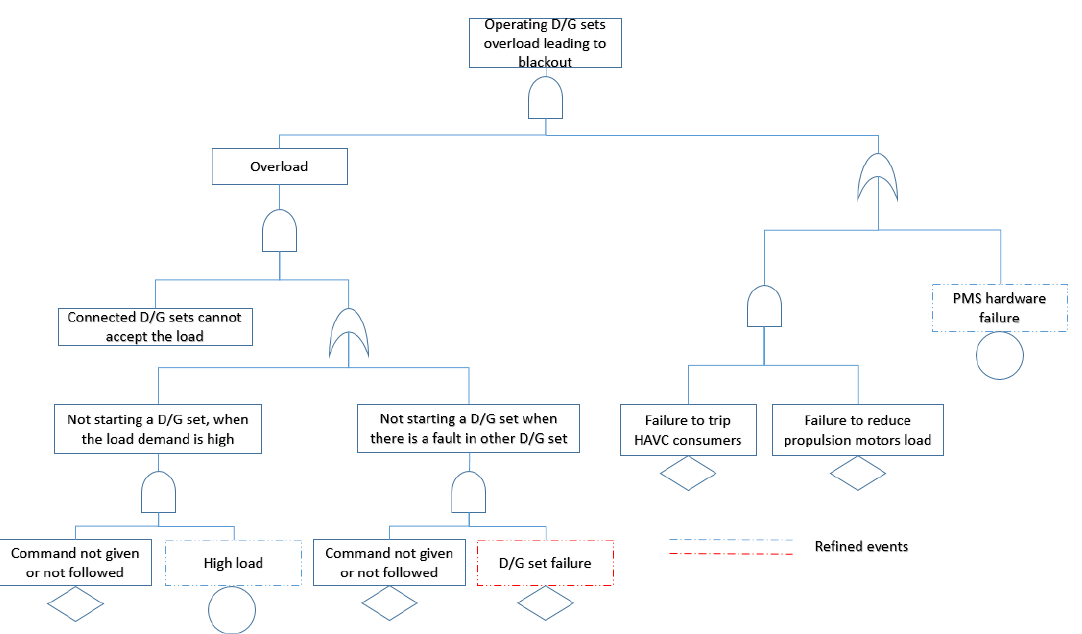
Figure 8. An extract from the refined Fault Tree.